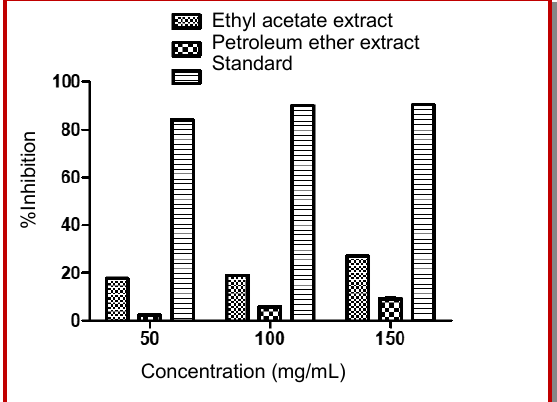
Concentration Figure 1: DPPH free radical scavenging activity of ethyl ace- tate and petroleum ether extract